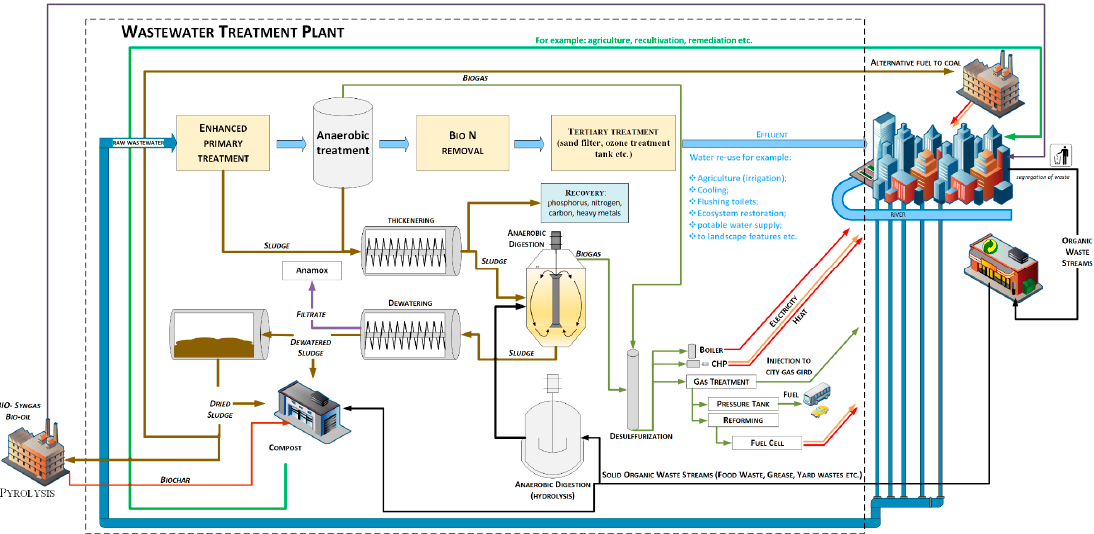
Figure 2. WWTP place in Smart City in the